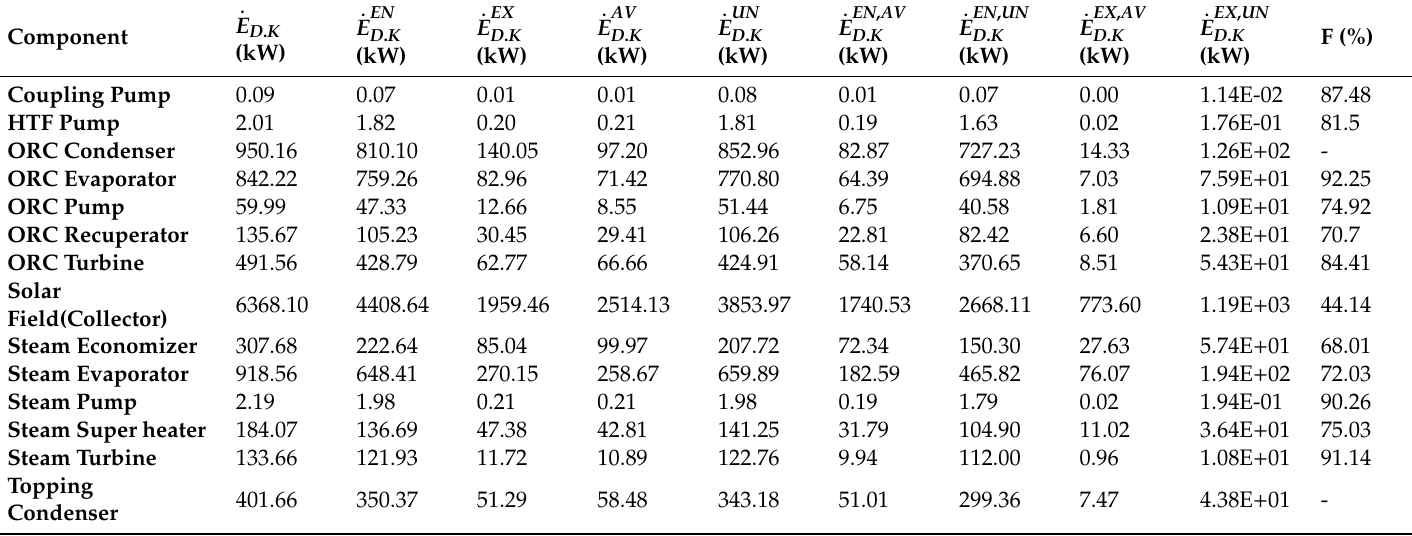
Table 14. Advanced exergy analysis of each component in the solar–geothermal cycle (SGPP).